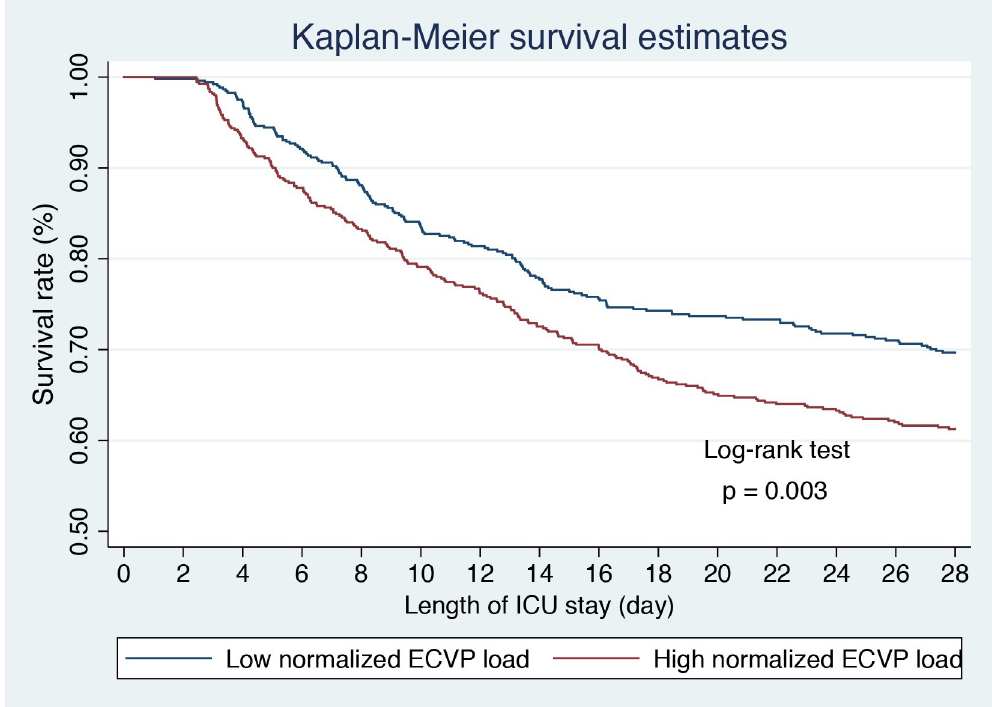
Fig 4. Kaplan-Meier survival analysis of patients with high or low normalized elevated central venous pressure load. Patients were divided into the high normalized elevated central venous pressure (ECVP) load group (n = 550) and the low normalized ECVP load group (n = 521) according to the median of normalized ECVP load. The 28-day mortality rate was significantly higher in patients with higher normalized ECVP loads than those with lower normalized ECVP loads.